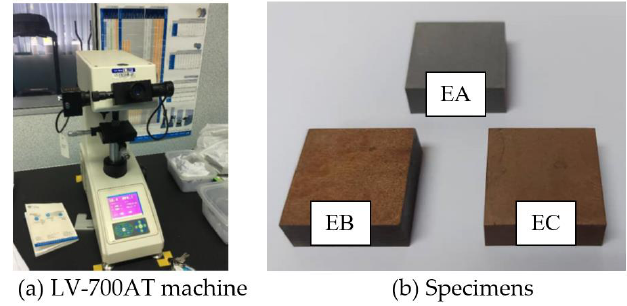
Figure 8. Hardness Test.